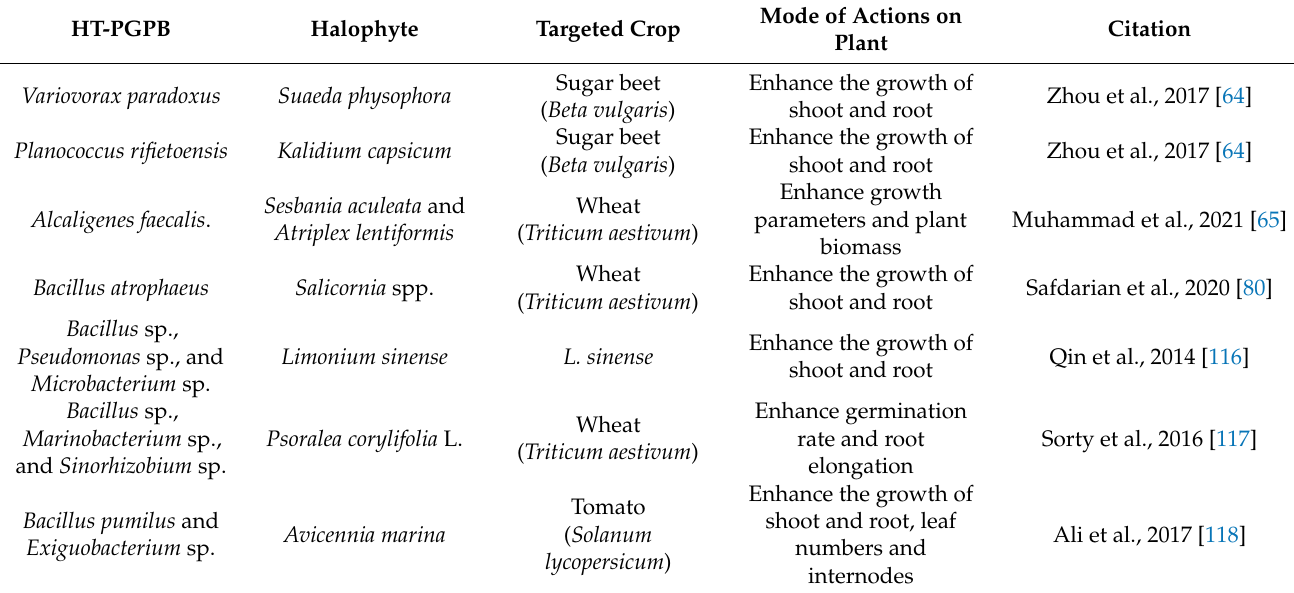
Table 3. Mode of actions of IAA-producing HT-PGPB on inoculated